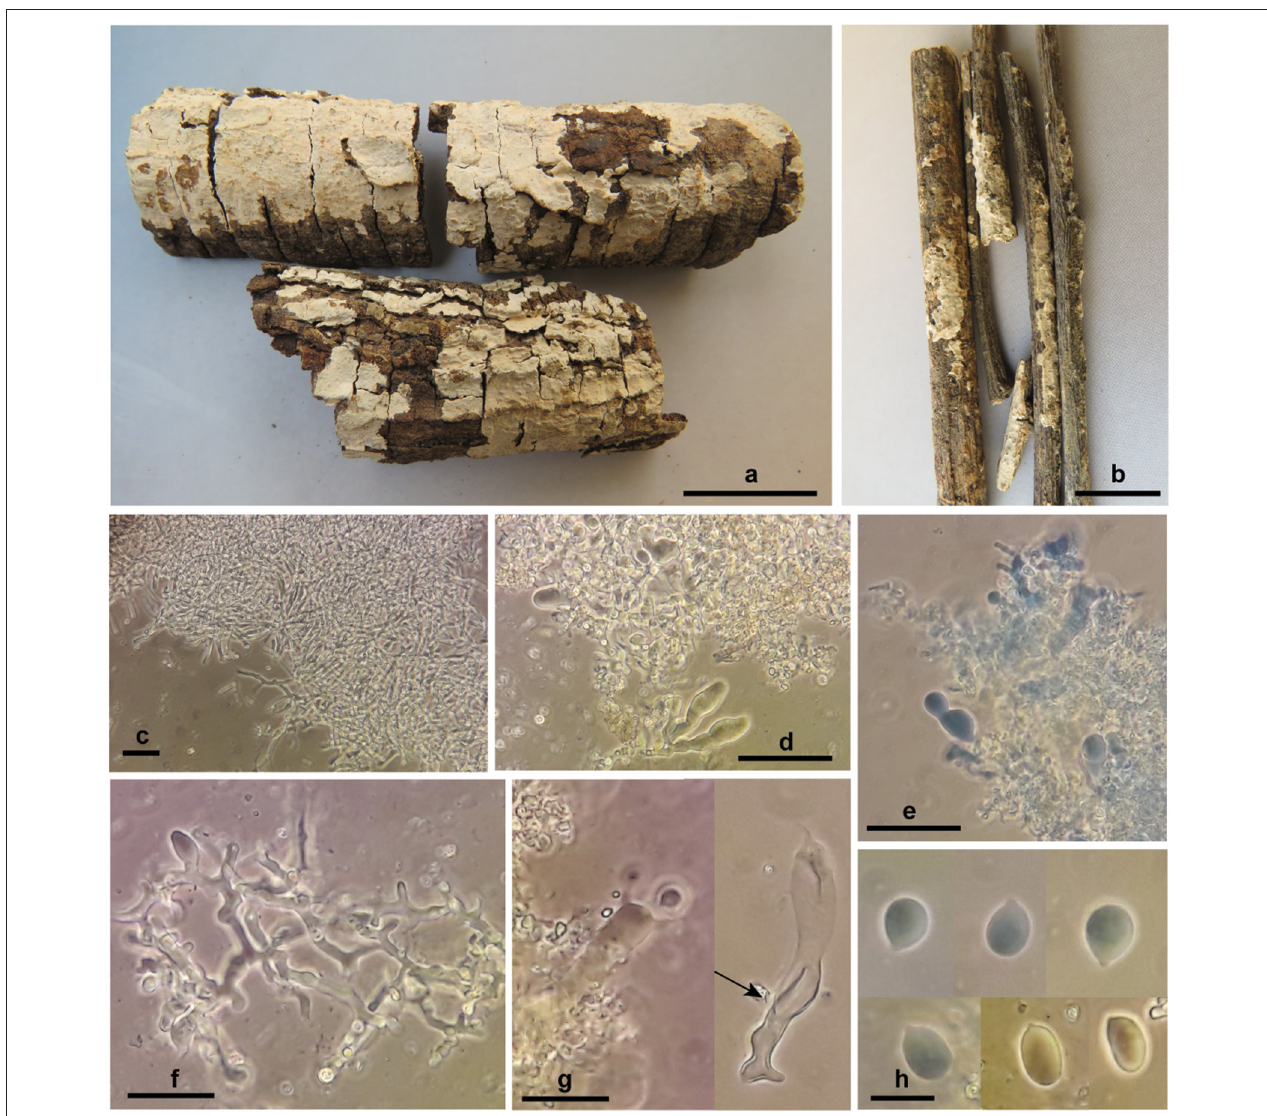
FIGURE 6 | Corticium thailandicum sp. nov. (a) basidiomata, holotype; (b) basidiomata, paratype; (c) subicular hyphae; (d–f) hymenium with basidioles and dendrohyphidia; (g) basidium embedded in crystalized dendrohyphidia (left), an old basidium with wall thickening in lower part (right, arrow); (h) basidiospores. Scale bars (a) 2cm; (b) 1cm; (c–e) 50 µ m; (f,g) 20 µ m; (h) 10 µ m. Photos: M. Ghobad-Nejhad.